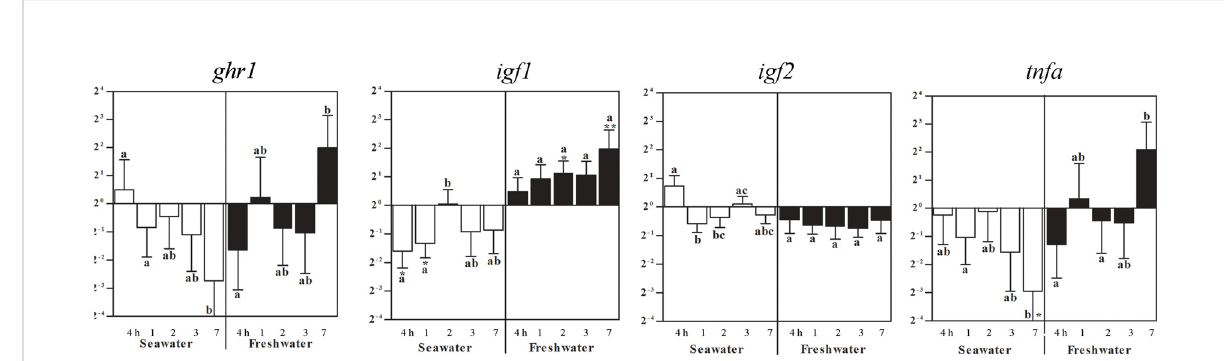
FIGURE 6 Effects of a seawater and freshwater exposures on the spleen ghr1 , igf1 , and igf2 and tnfa gene expressions. Relative changes (log 2 , y-axis) of mRNA expression at 4 h, 1, 2, 3 and 7 days (x-axis) after exposure to seawater (white columns) and restitution of freshwater (black columns). Bars represent mean ratios between treated and control groups ± SEM and asterisks show signi fi cant differences: * p < 0.05; ** p < 0.005. Bars within treatment groups that do not share any letters are signi fi cantly different from each other: p < 0.05, e.g., tnfa seawater expression after 7 days was signi fi cantly lower than in untreated controls, and differed to fi sh after 1 day in seawater, but not after 4 h, 2 or 3